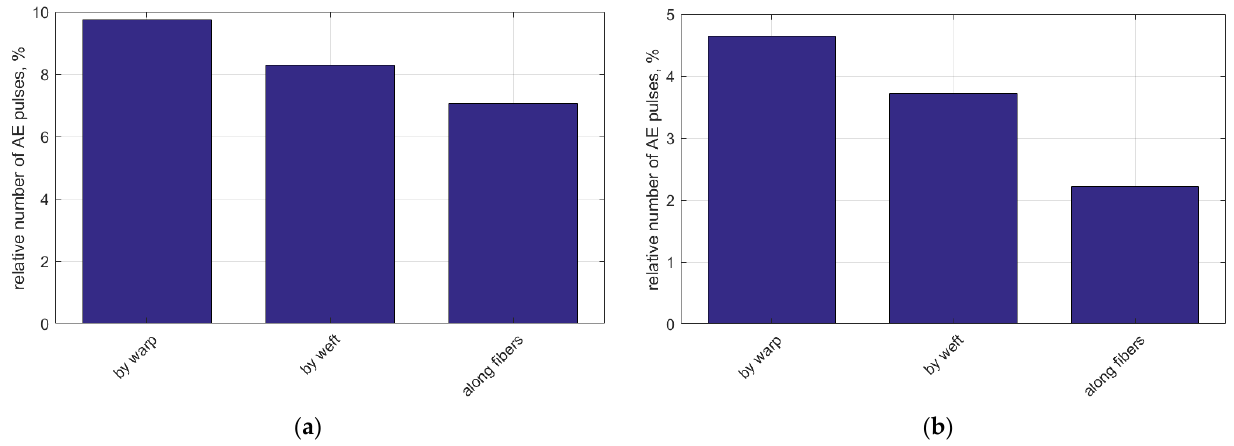
Figure 15. Relative number of detected AE pulses in each of the laboratory experiments (uniaxial tension of the woven laminate sample cut along the warp and weft directions ( a ) and the unidirectional CFRP sample cut along the fiber direction ( b ) at different background signal intensities ( a –0.9 mV, b –10 mV).